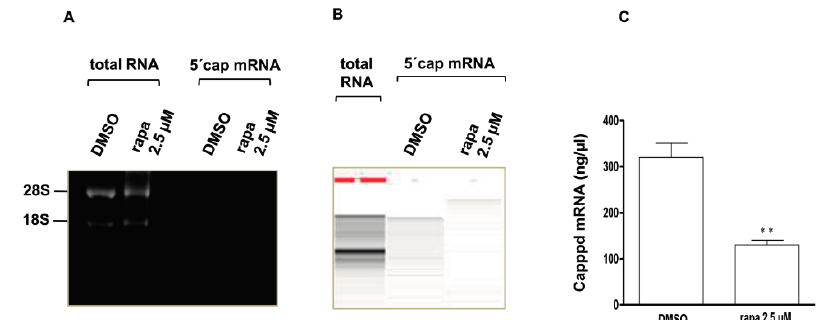
Figure 7. Rapamycin enhanced mRNA decapping activity: CCRF-CEM cells were treated with either rapamycin or vehicle control for one hour and ( A ) Total RNA was extracted from the cells, while the capped mRNAs were specifically isolated from total RNA using terminator exonuclease and lithium chloride precipitation. The removal of 18S and 28S rRNA from total 5'-capped mRNA was confirmed by 1.5% agarose gel electrophoresis; ( B ) After confirmation of 5'-capped mRNA purity, the total 5'-capped mRNA was run on the microchip gel and quantified; and ( C ) Bar diagram representation of five independent experiments (mean ± SEM), where significance was determined by Student’s t -test (** p <